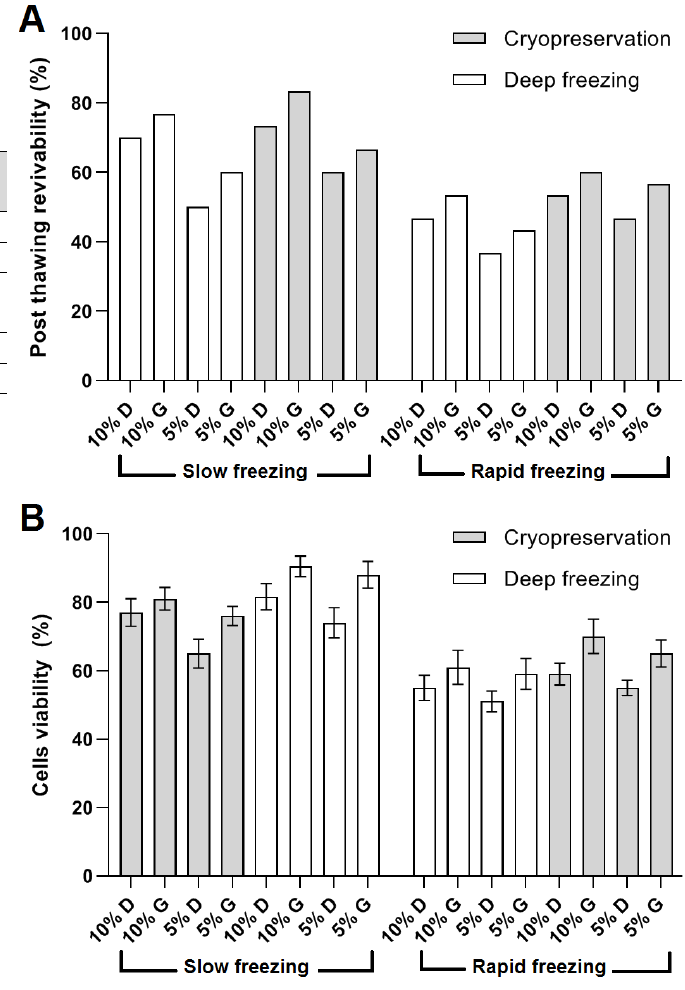
Figure 2. Post-thawing Vero cells revivability (A) and viability (B) after 18 months of preservation at under two concentrations of cryoprotectants (D: DMSO and G: Glycerol), two freezing methods (Rapid and Slow freezing), and two preservation temperatures (Deep freezing at -80°C and Cryopreservation at -